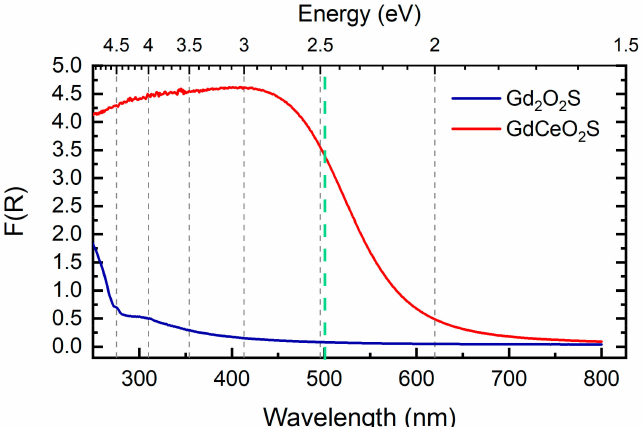
Figure 2. UV-visible diffuse reflectance spectra of Gd 2 O 2 S and GdCeO 2 S nanoplatelets. The y -axis is expressed as the Kubelka-Munk function F(R) calculated from obtained apparent absorbance. The dashed line indicates the wavelength at which the following ROS production experiments were carried